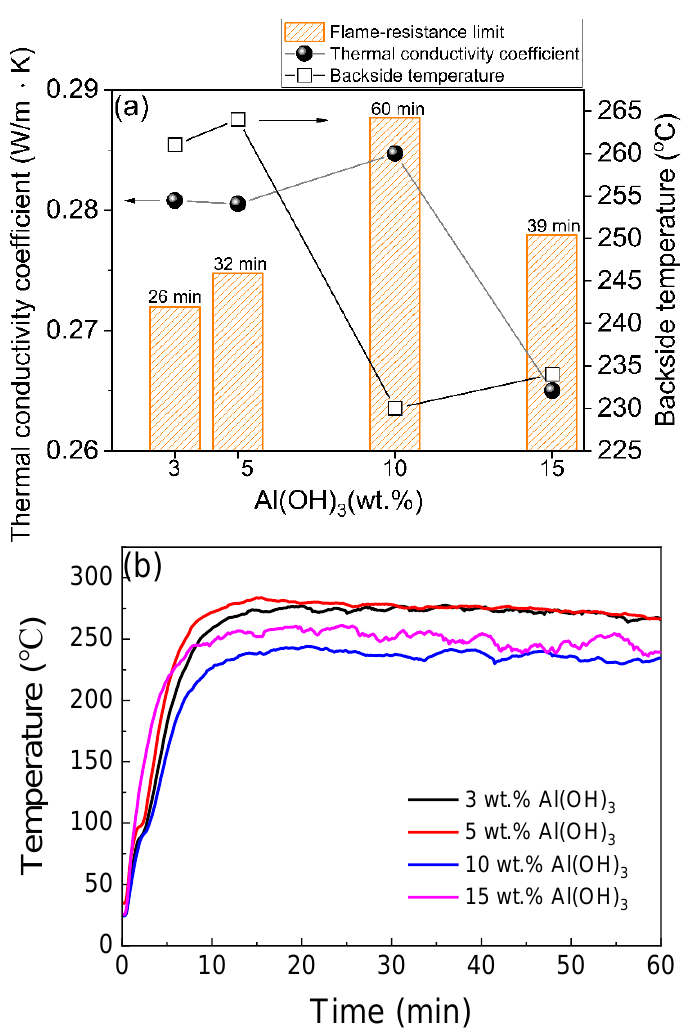
Figure 6. ( a ) Thermal conductivity, backside temperature for steel substrate, flame-resistance limit relating to different contents of aluminum trihydroxide, and ( b ) flame-resistance rating of the MKPCs. (magnesia/KH 2 PO 4 molar ratio = 4; wollastonite:vermiculite = 20:10 wt.%).